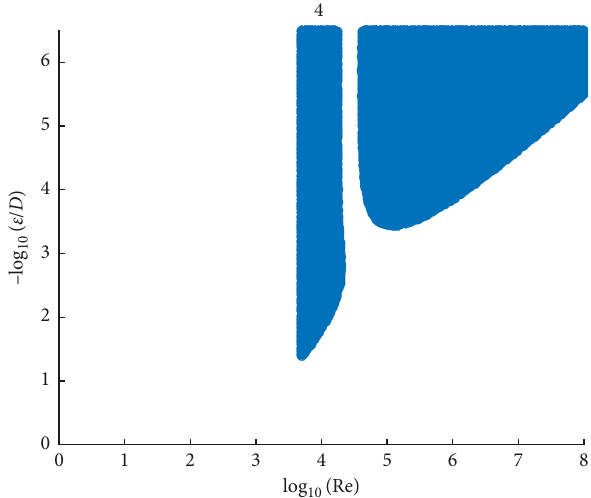
Figure 3: Decreased maximal number of required iterations from 6 8 for solving Colebrook’s equation in to 4 to reach accuracy of 10 Newton’s procedure when calculation goes through the trans- − mission factor x where the initial starting point is with the fixed value: x 0 6.44569593948452. (cid:31)